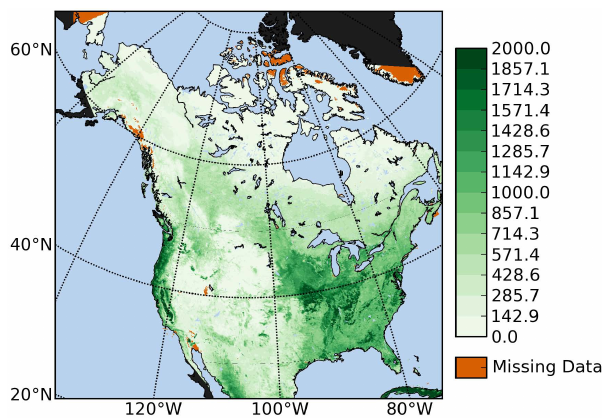
Fig. 7. The 2002 annual integrated VPRM GEE, gCm − 2 yr − 1 . PFT–all-data VPRM parameters. Black areas are outside of the study domain.